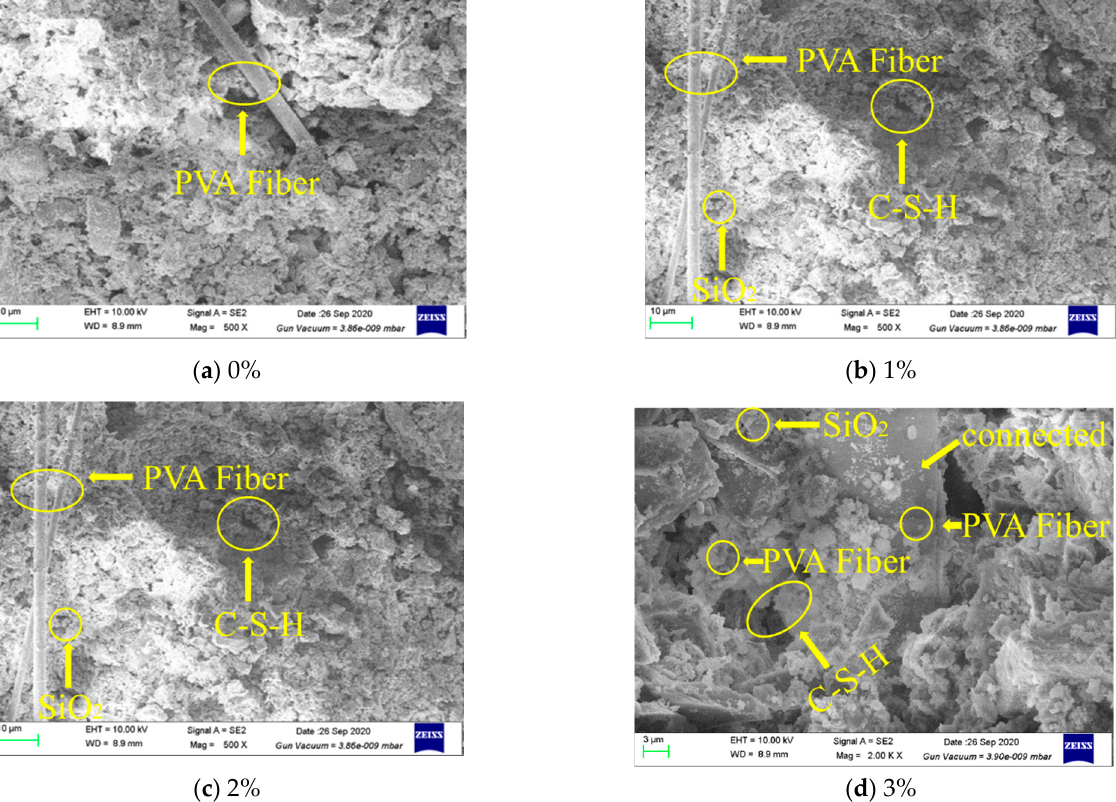
Figure 9. SEM images of the microstructure of recycled concrete with different NS contents and PVA fibers.